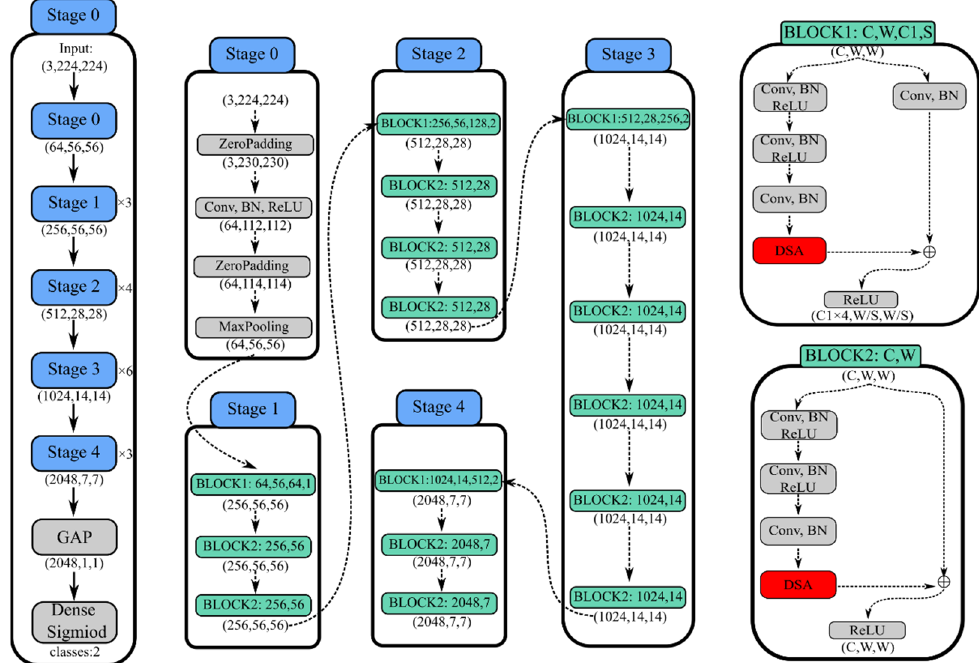
Figure 4. Our proposed DSA-ResNet50 model for fire classification.